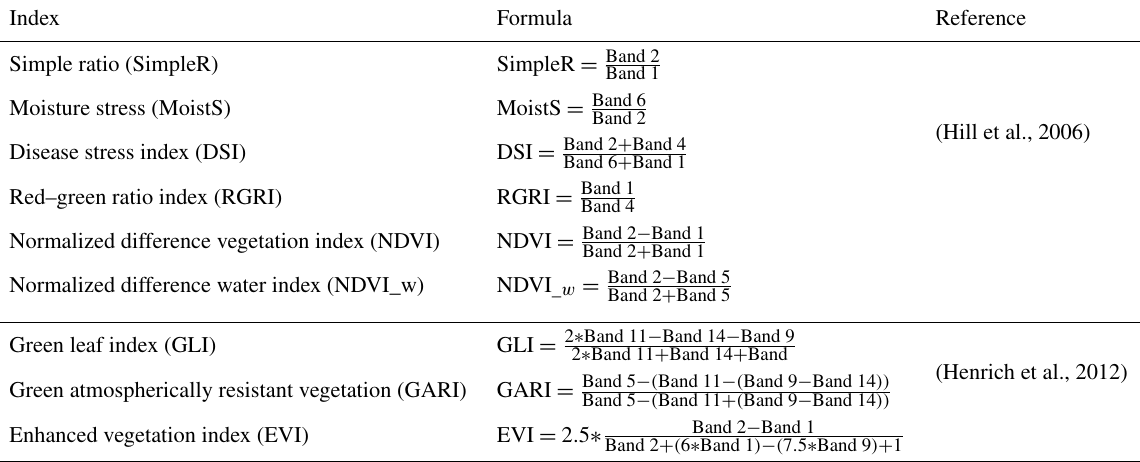
Table B2. Daily vegetation indexes computed using the MODIS reflectance bands described in Table